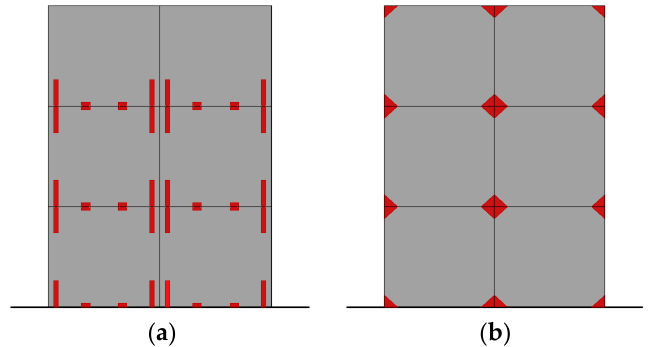
Figure 4. Connection arrangements for shear walls; ( a ) A-3 system; ( b ) B-3 system.